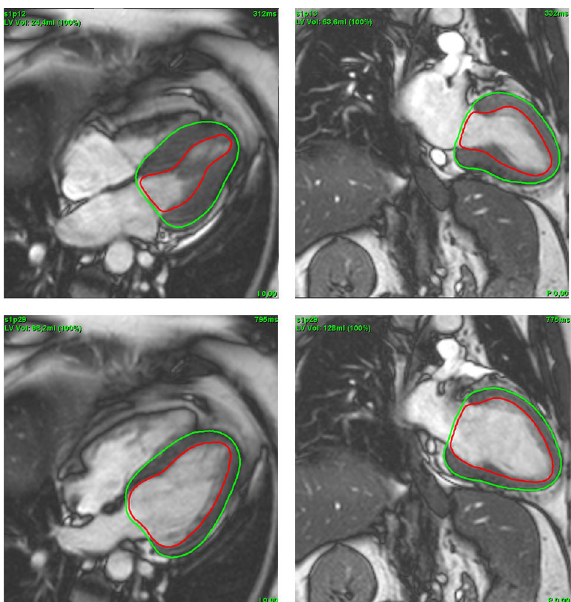
Figure 2. Cardioavascular magnetic resonance LAX images with automated contouring at end systole (top) and end diastole (bottom); 4CV (left) and 2CV (right). 2CV, 2 chamber view; 4CV, 4 chamber view; LAX, long